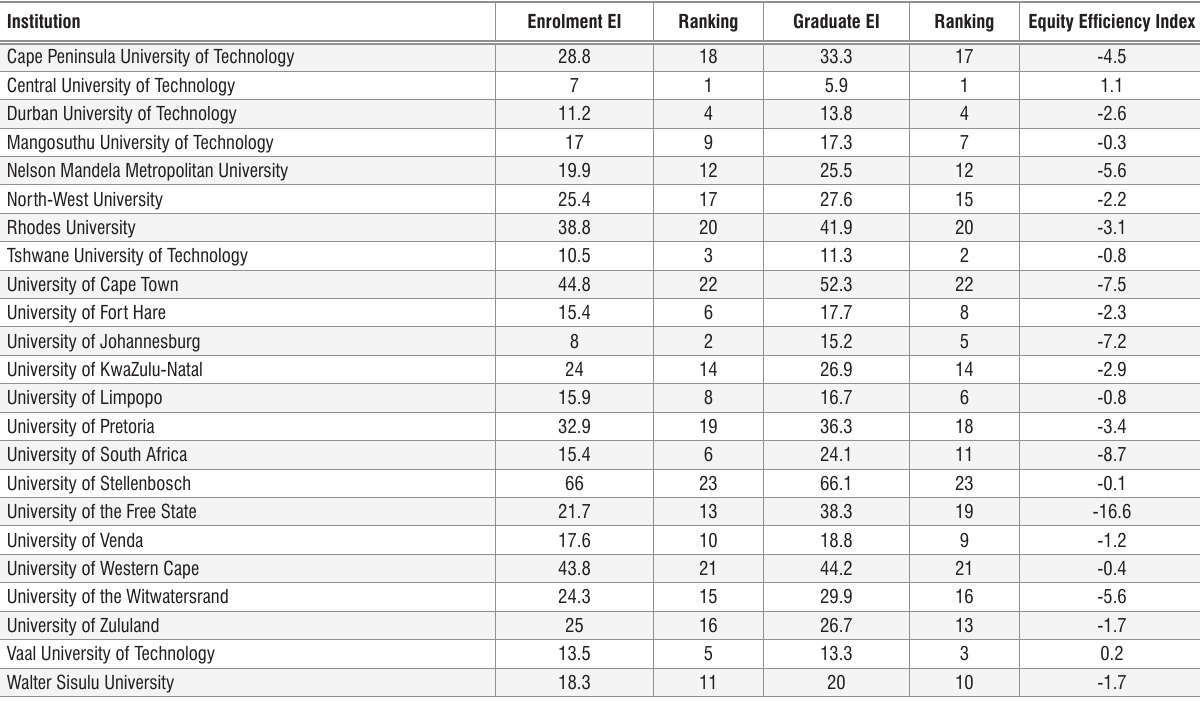
Equity Indices (EIs) for South African student enrolment and graduation at South African universities ( n